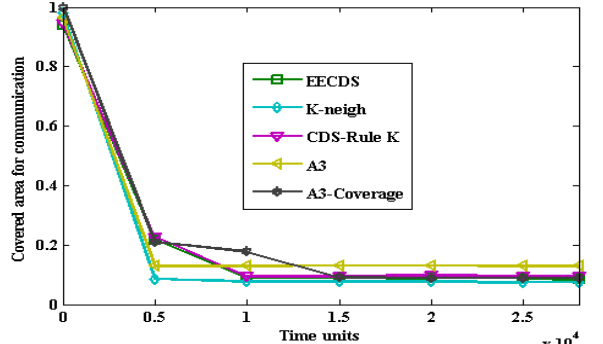
Figure 5 . Network lifetime for communication coverage